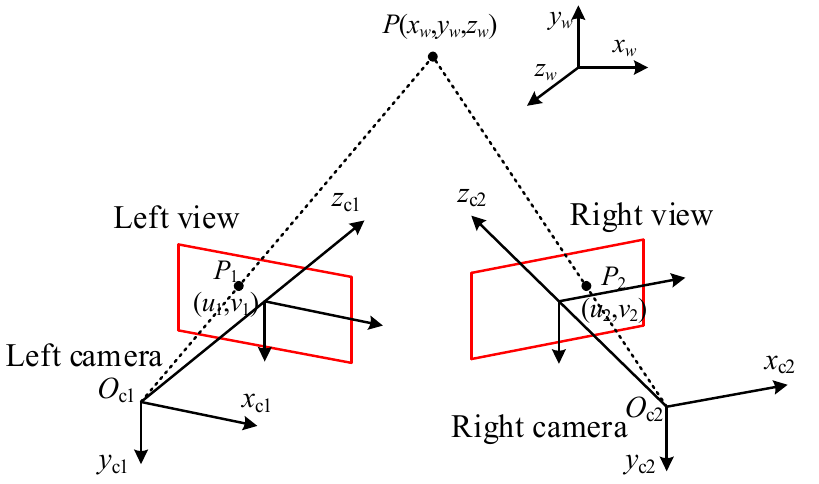
Figure 1. Principle of three-dimensional coordinate reconstruction algorithm.